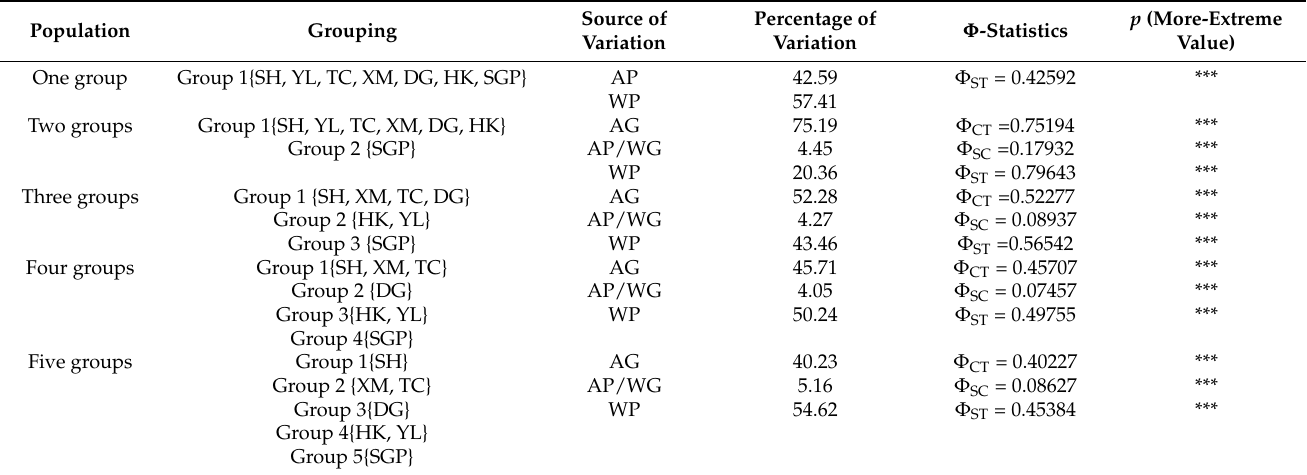
Table 3. The results of AMOVA for P. sanguinolentus in seven populations in East Asia.